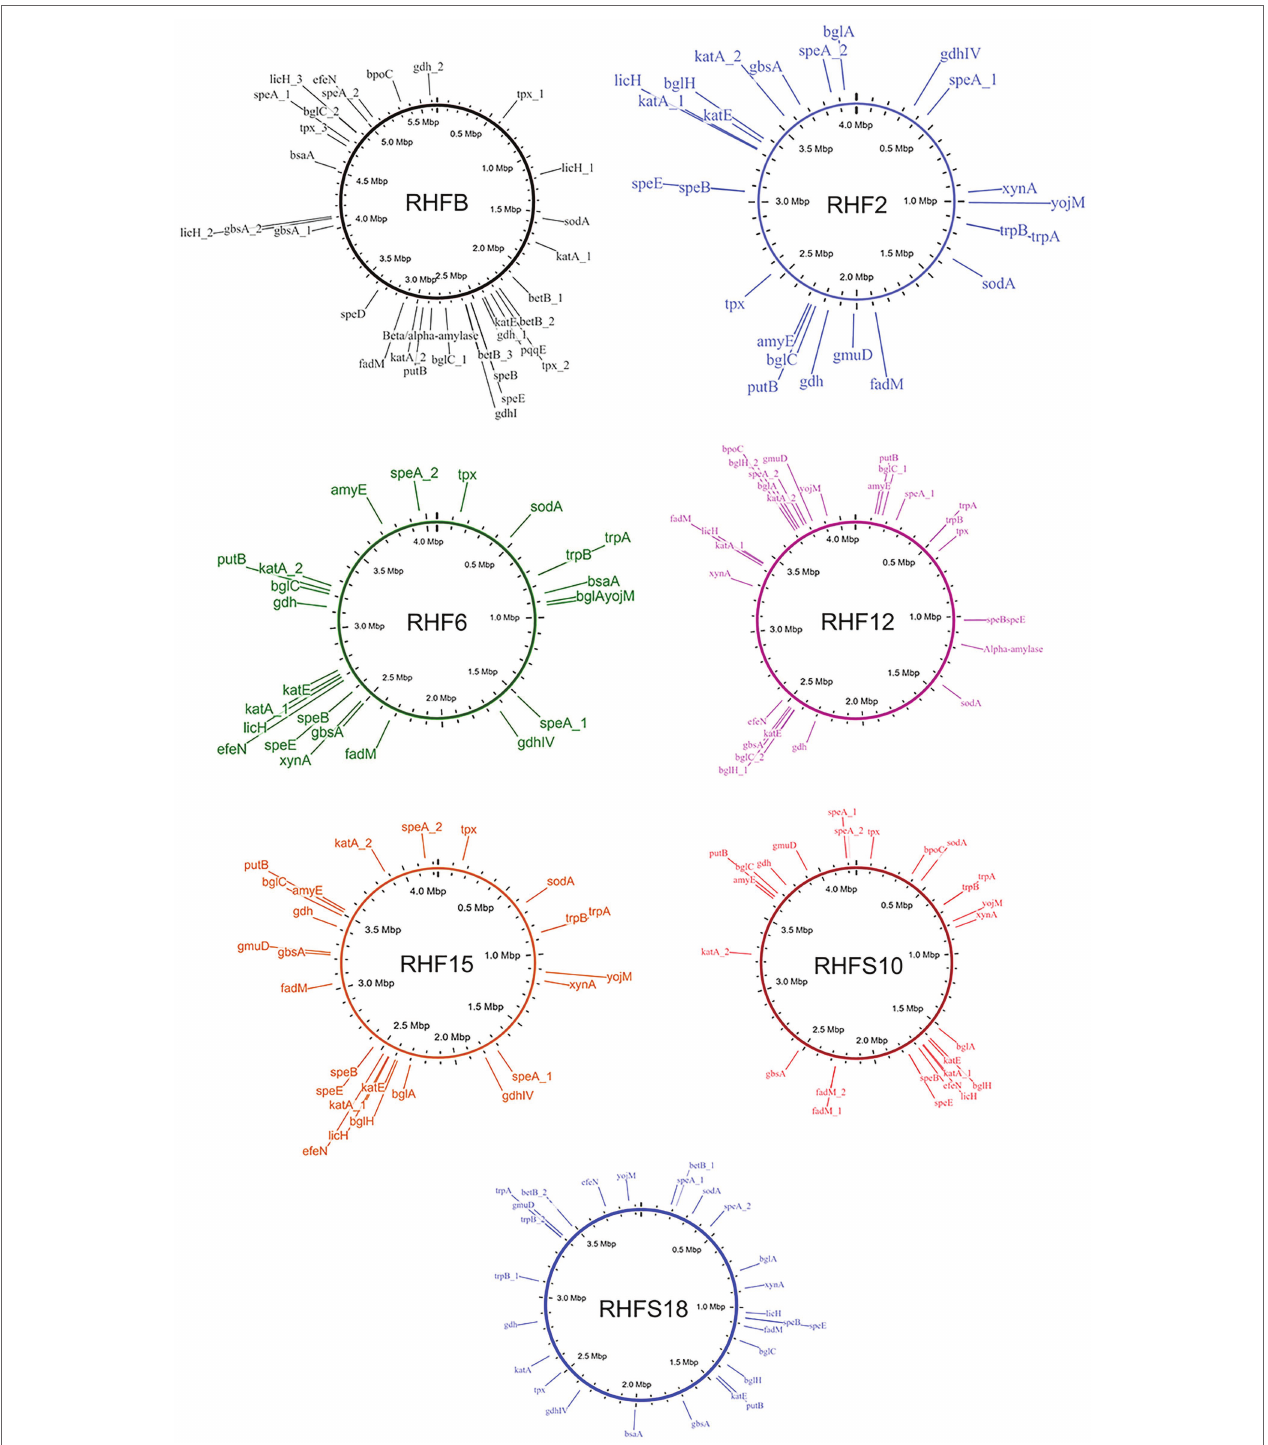
FIGURE 3 | Whole genome representations of the seven isolates showing the location of the identified PGP trait genes.